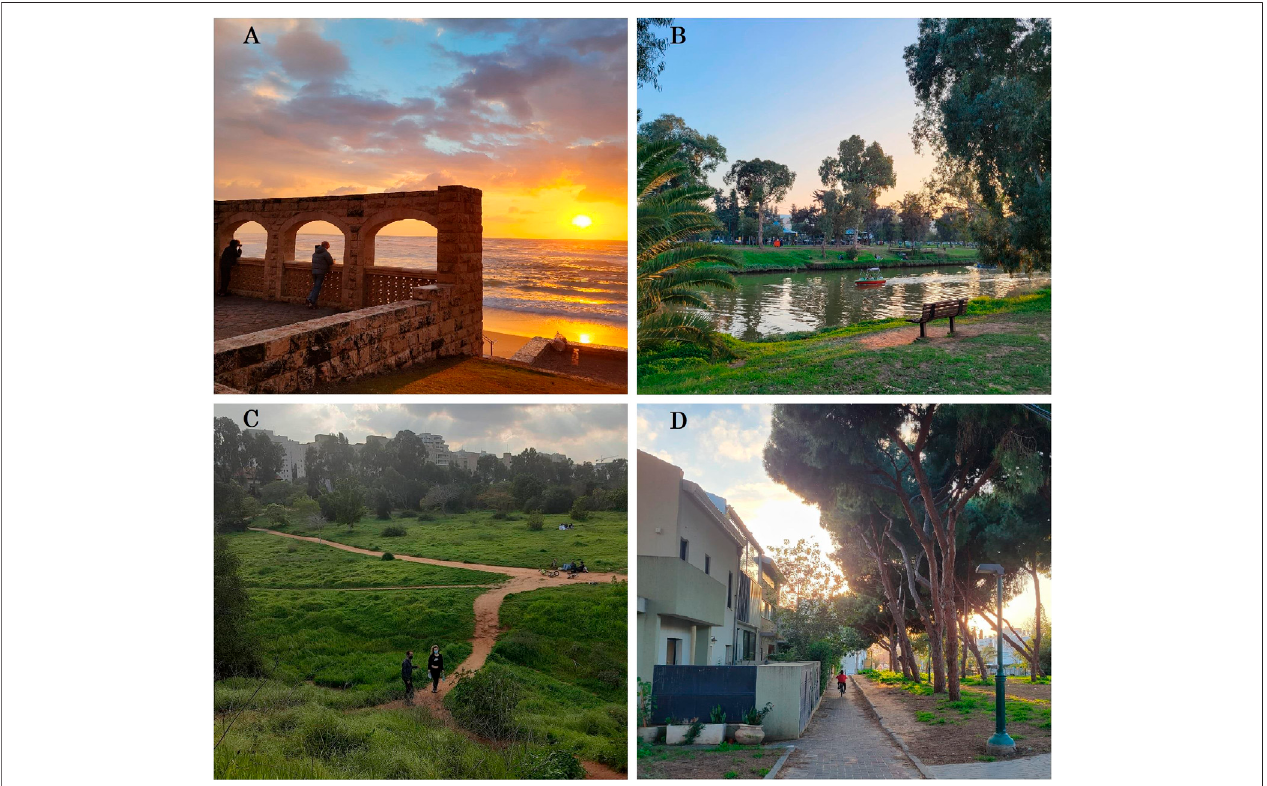
FIGURE 2 | Examples of urban nature sites in Tel Aviv-Yafo (with their corresponding numbers in Figure 1 in parentheses): (A) Givat Aliya Beach and Gan Yitzhak Sadeh (39), (B) Nahal Yarkon Sportek section (14), (C) Afeka Center (31), and (D) Ramat Aviv A (52).